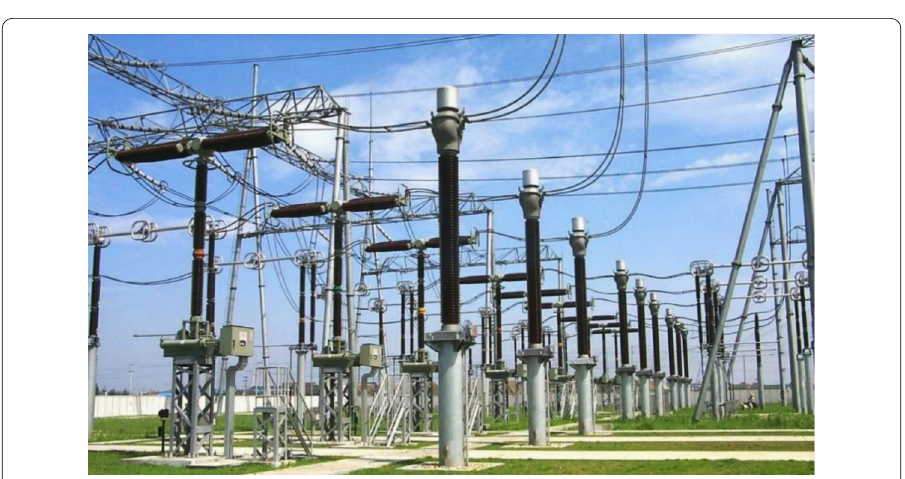
Figure 1 A view of a power electricity transmission and distribution